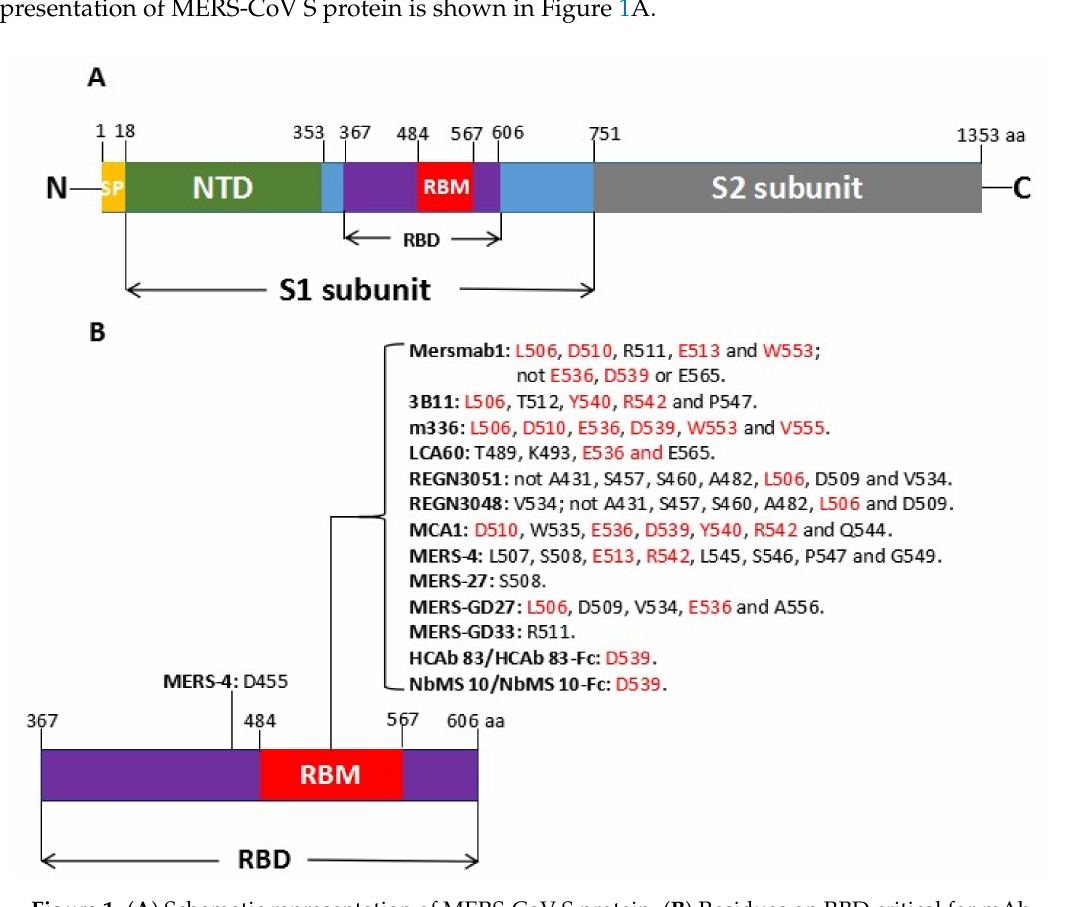
Figure 1. ( A ) Schematic representation of MERS-CoV S protein. ( B ) Residues on RBD critical for